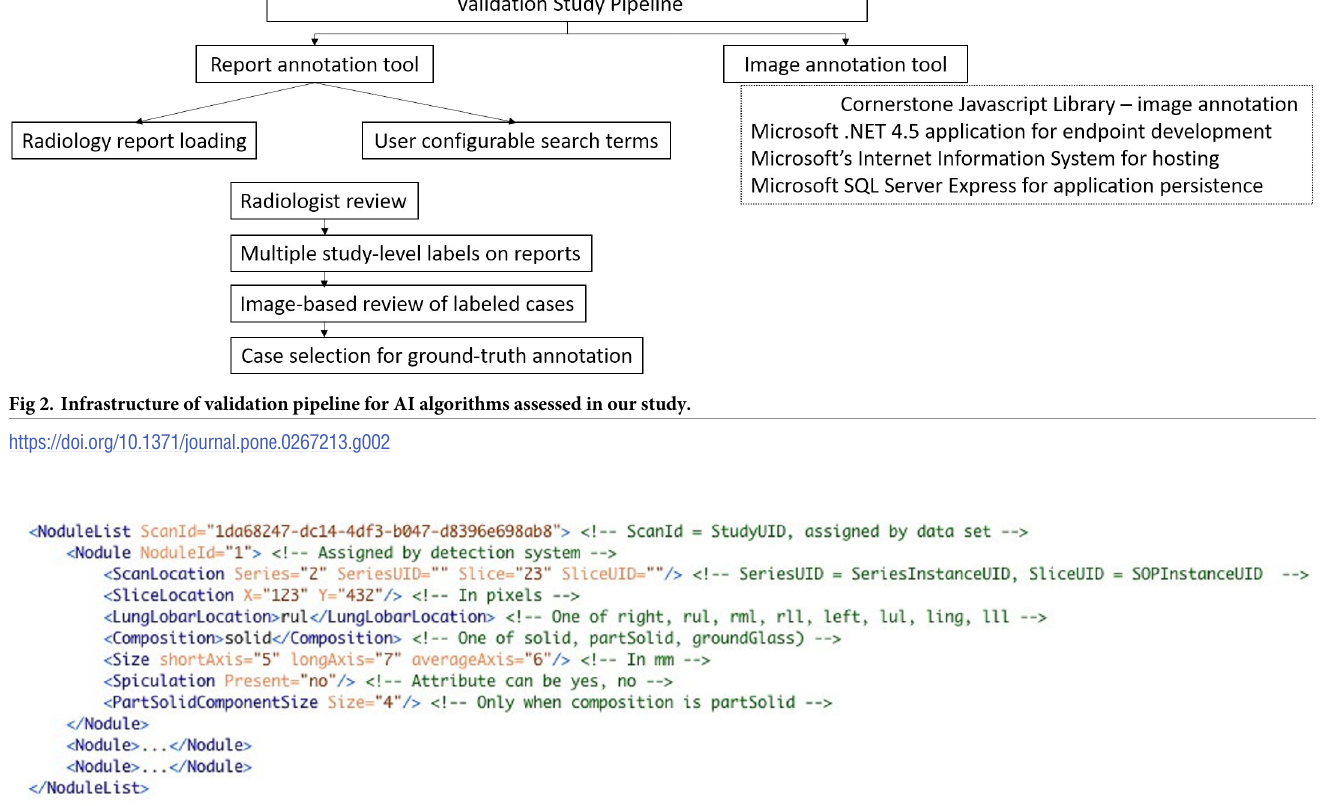
Fig 3. Vendor output data schema defined in Extensible Markup Language